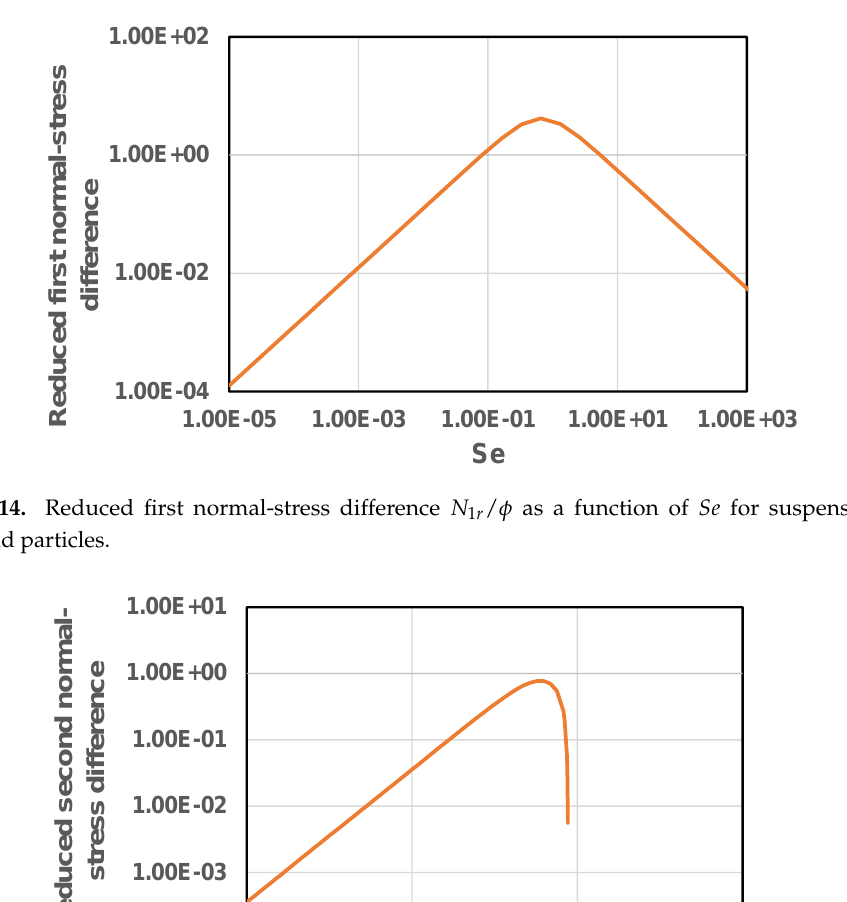
Figure 13. Intrinsic viscosity [ η ] as a function of Se for suspensions of soft solid particles.